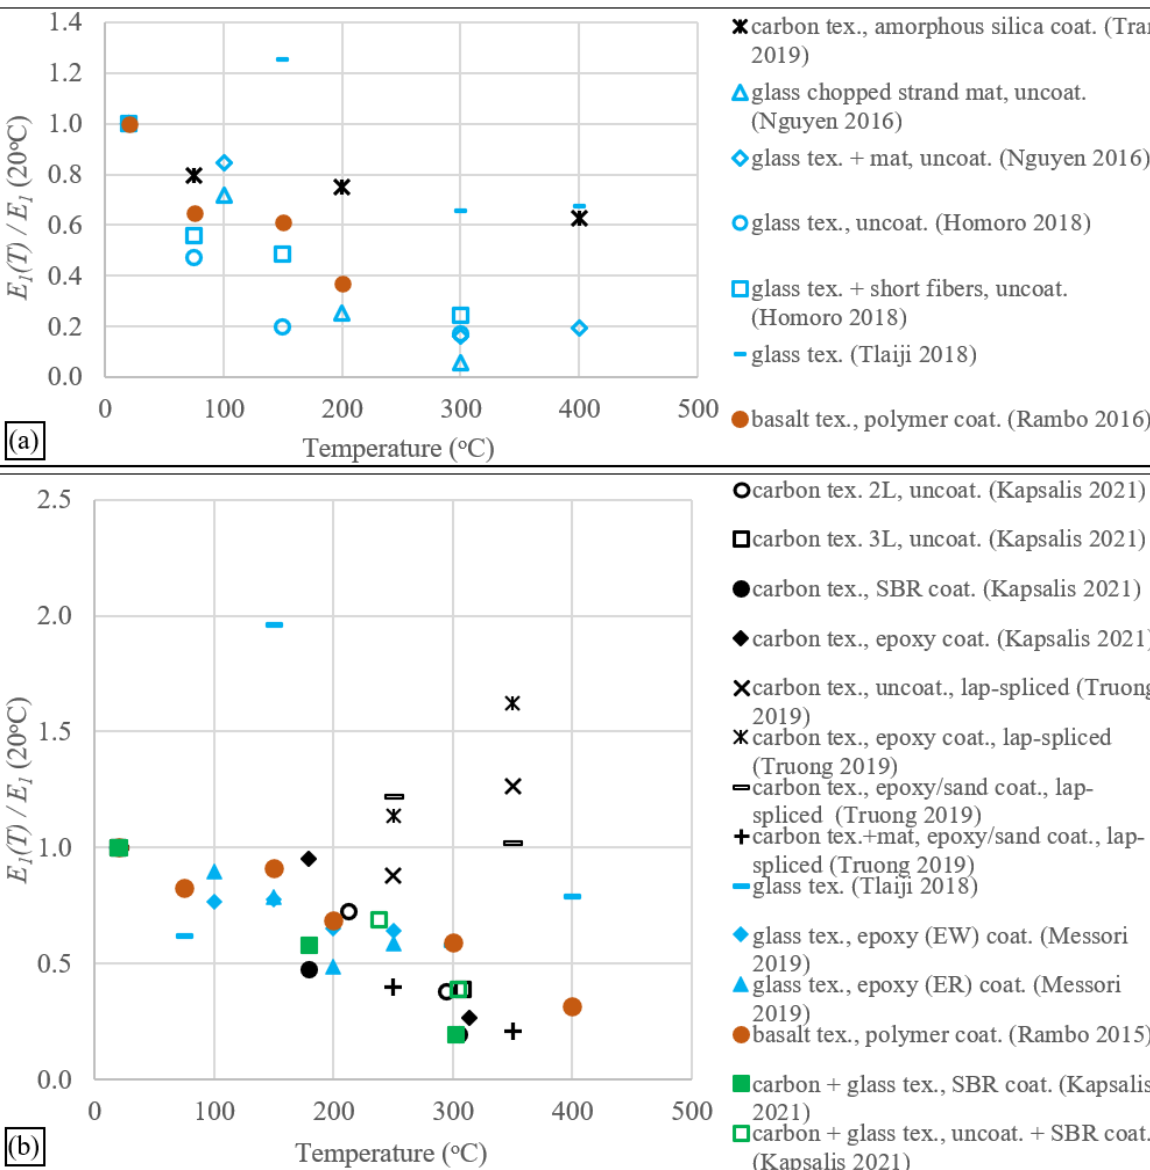
Figure 4. Elastic modulus ( E 1 ) versus exposure temperature for various TRC compositions; ( a ) specimens loaded while in heated conditions; ( b ) specimens tested after cooling down.